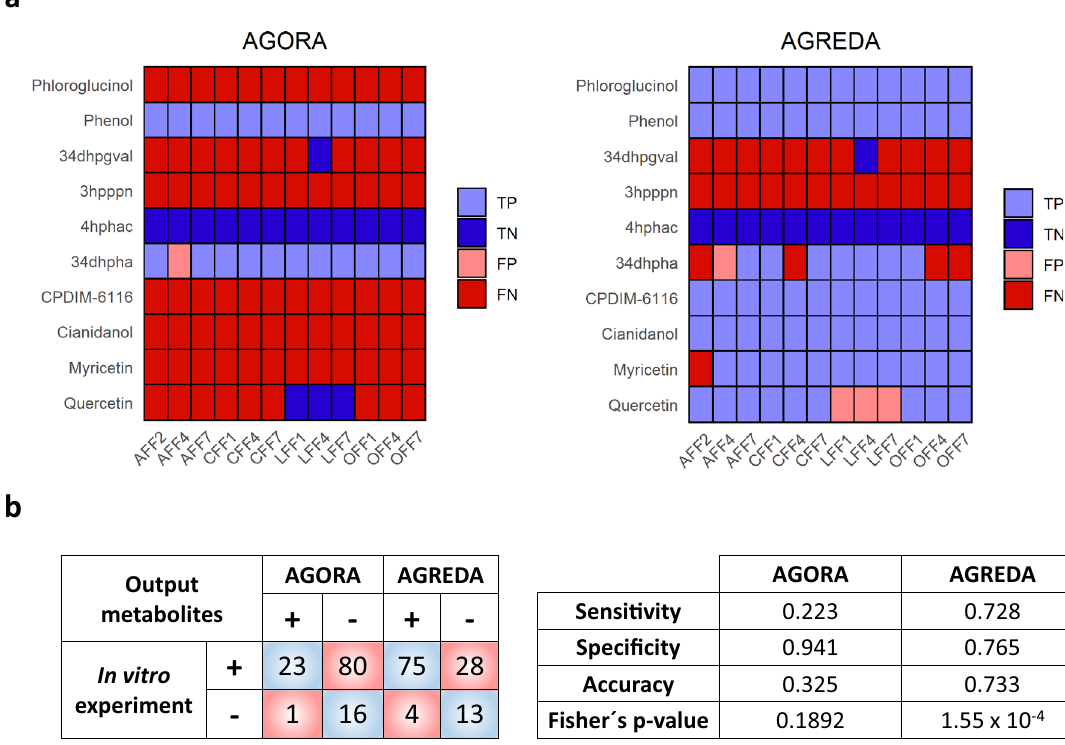
Fig. 4 In vitro experimental comparison of the predictions by AGREDA and AGORA. a Comparison of AGREDA and AGORA for predicting the presence (positive) or absence (negative) of ten output microbial compounds derived from the fermentation of lentils with children feces and measured with a targeted metabolomics approach. b Confusion matrix and statistical details of the comparison shown in a . Sensitivity was determined as TP/(TP + FN), speci fi city as TN/(FP + TN), and accuracy as (TP + TN)/(TP + TN + FP + FN). The reported Fisher ’ s p value was two-sided. 34dhpgval 5-(3 ’ ,4 ’ - Dihydroxyphenyl)-gamma-valerolactone, 3hpppn 3-(3-hydroxy-phenyl)propionate, 4hphac 4-hydroxyphenylacetate, 34dhpha (3,4-dihydroxyphenyl) acetate, CPDIM-6116 dihydrocaffeic acid; “ AFF2, ” “ AFF4 ” , and “ AFF7 ” denote samples 2, 4, and 7 from children allergic to cow ’ s milk, respectively; “ CFF1, ” “ CFF4, ” and “ CFF7 ” denote samples 1, 4, and 7 from celiac children, respectively; “ LFF1, ” “ LFF4, ” and “ LFF7 ” denote samples 1, 4, and 7 from lean children, respectively; “ OFF1, ” “ OFF4, ” and “ OFF7 ” denote samples 1, 4, and 7 from obese children, respectively; TP true positives, TN true negatives, FP false positives, FN false